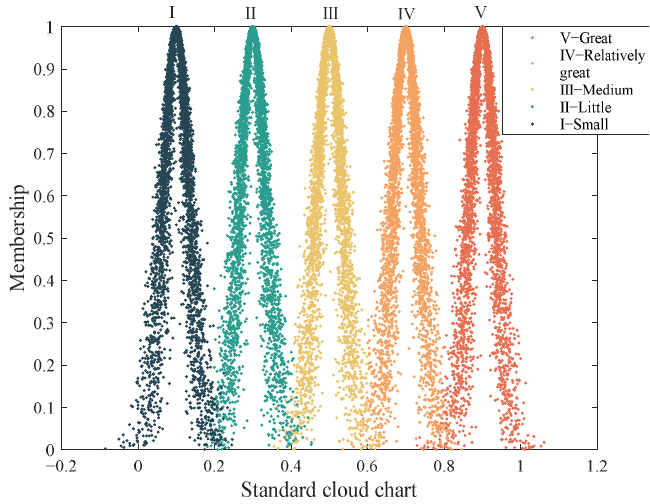
Figure 2. Standard cloud map of the evaluation interval. Membership calculation and comprehensive risk assessment level